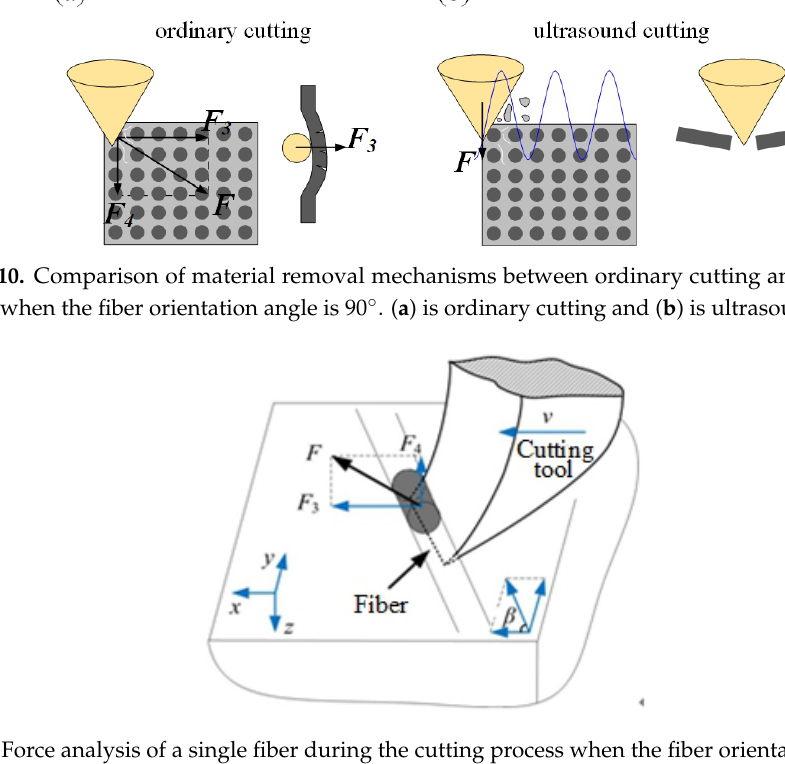
Figure 11. Force analysis of a single fiber during the cutting process when the fiber orientation angle is 90 ◦